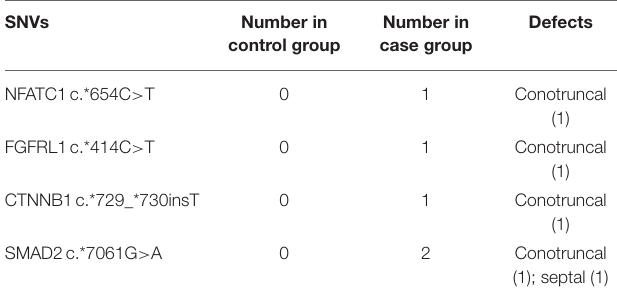
TABLE 4 | The distribution of four rare SNVs in control and case groups. TABLE 3 | A list of differentially distributed miRNAs between cardiac NCCs and non-NCCs. SNVs Number in microRNAs Relative Relative Log2 fold change expression level in expression level in cardiac NCCs non-NCCs